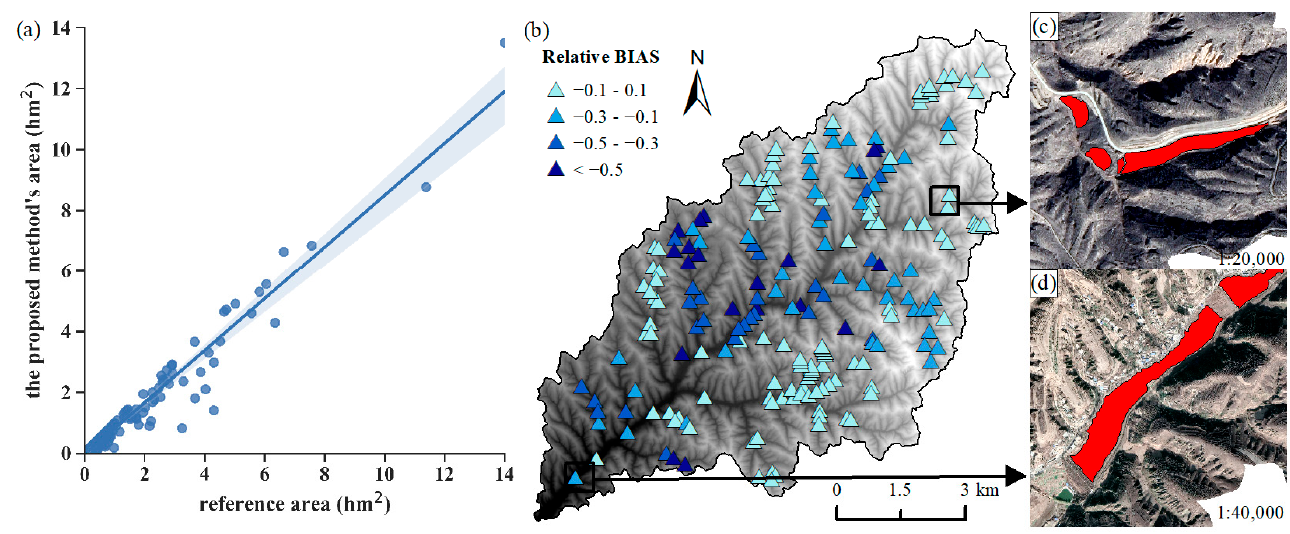
Figure 8. ( a ) Correlation between the dam-controlled areas from the proposed method and the